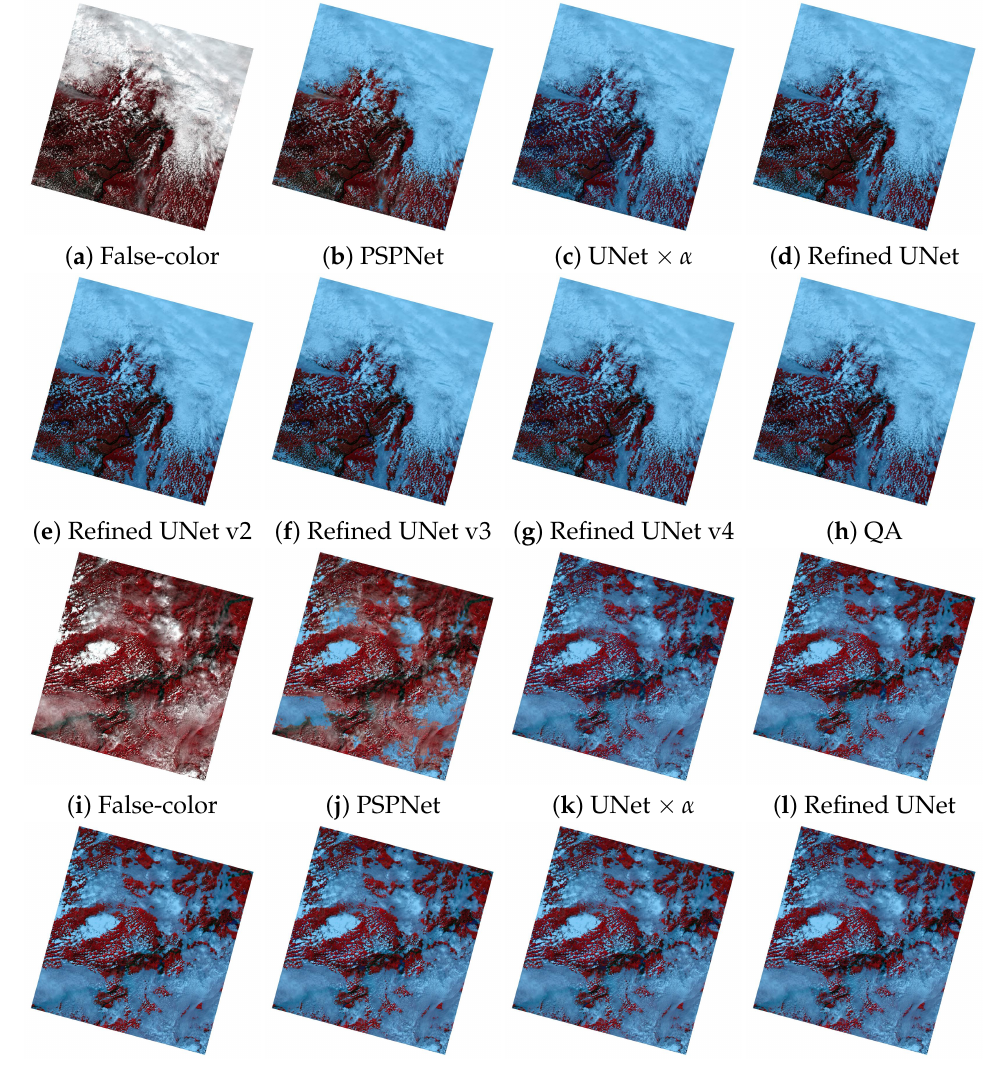
Figure 4. Typical visual examples of full images